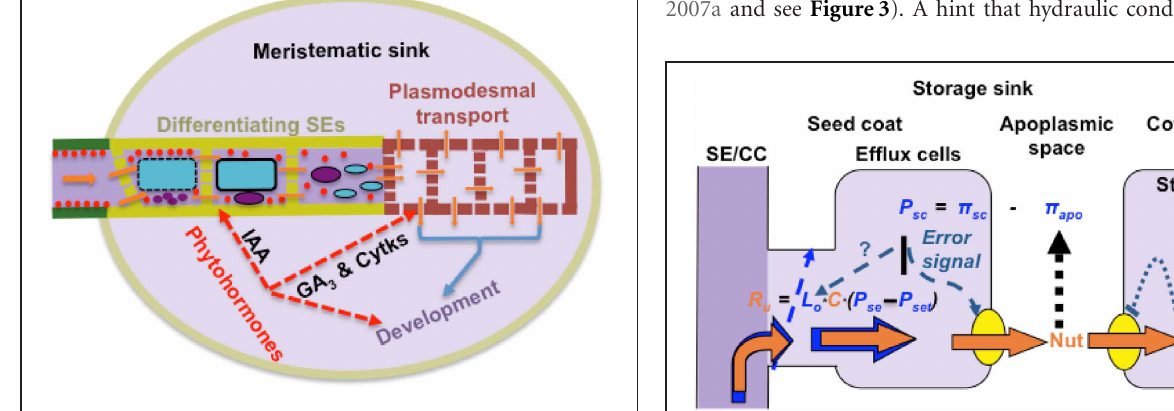
FIGURE 3 | Turgor homeostasis model of phloem unloading in developing seeds of grain legumes. Sucrose uptake by, and storage, in cotyledons is coupled through a negative feedback transcriptional regulation of sucrose transporter activity mediated through intracellular sucrose levels. Activities of seed coat sucrose effluxers are coordinated with cotyledon demand by a turgor-homeostat mechanism that osmotically ( π ) detects alterations (error signal) in apoplasmic sucrose pool sizes as a deviation from a turgor ( P) set point. Symplasmic unloading from release phloem SE/CC complexes by bulk flow is regulated by plasmodesmal hydraulic conductances ( L o ) under control of the turgor homeostat functioning as a central control hub to regulate resource flow from SE/CC complexes to ultimate storage in